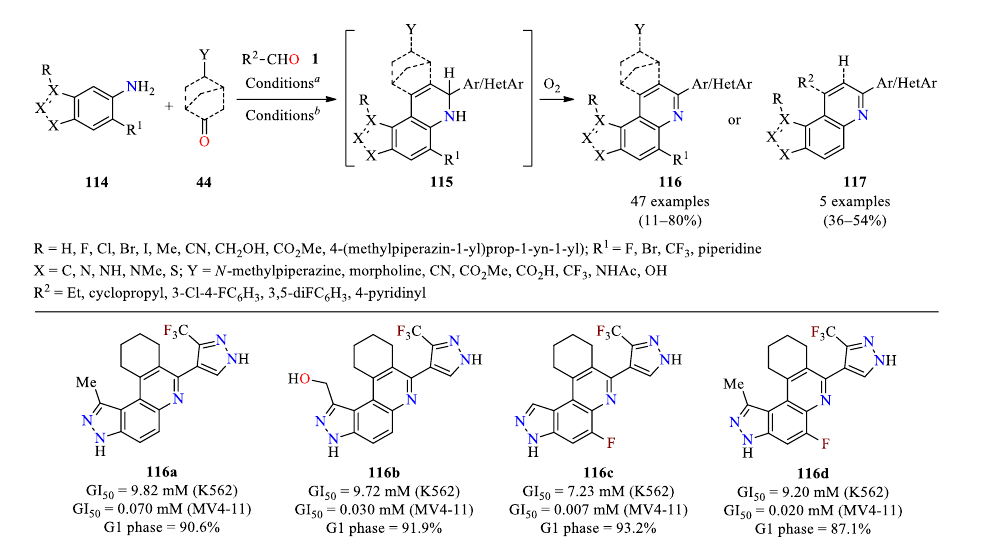
Scheme 12. Three-component synthesis and anticancer evaluation of 3 H -pyrazolo[4,3- f